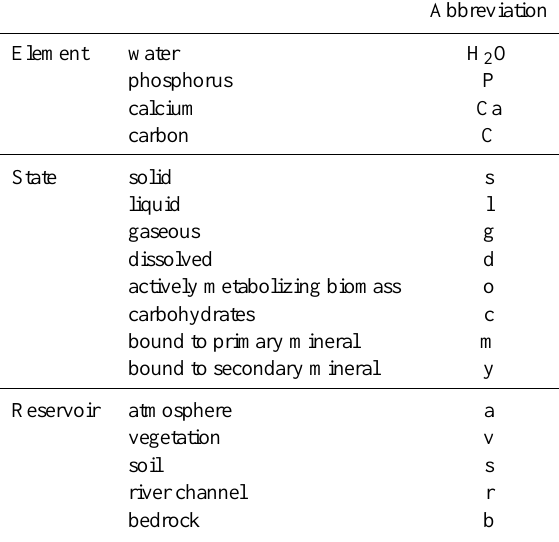
Table 1. Abbreviations of variable names. State variables are con- ventionally named A c , where A is a chemical compound, e.g. P, or b a state variable such as temperature T , b is the state of matter, e.g. s for solid (see Table 1). Fluxes have names of the form f A sa , where bt b is start and t the end state (to consider phase change) and s is the start and a the end location. P root uptake from soil to vegetation is thus named f P sv . Pools start with the element, fluxes start with f , d parameters with p , and constants with c